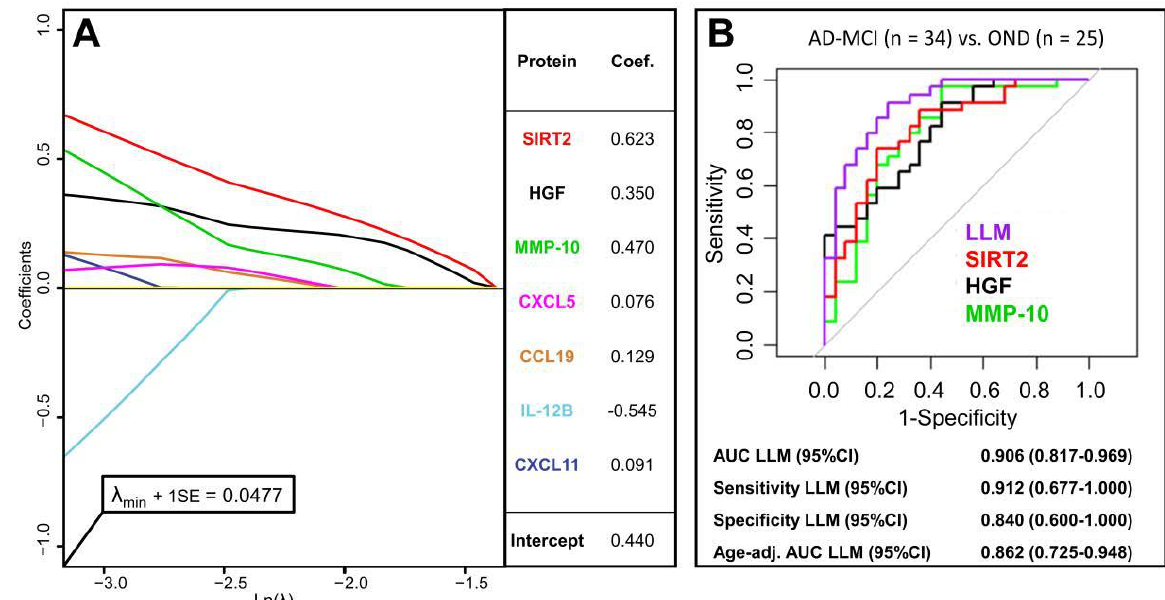
Figure 2. ( A ) LASSO coefficients in function of the shrinkage parameter λ from λ = 0.25924 ( at least 1 coefficient ≠ 0 ) to λ = 0.0477 ( λ min + 1SE) . The coefficients found for λ min + 1SE were used to build a LASSO-based logistic model (LLM). ( B ) ROC curves relative to the diagnostic performance of LLM and the three proteins z-scores most contributing to the model, namely SIRT2, HGF, and MMP-10. For abbreviations of PEA-tested proteins, see Table S1.